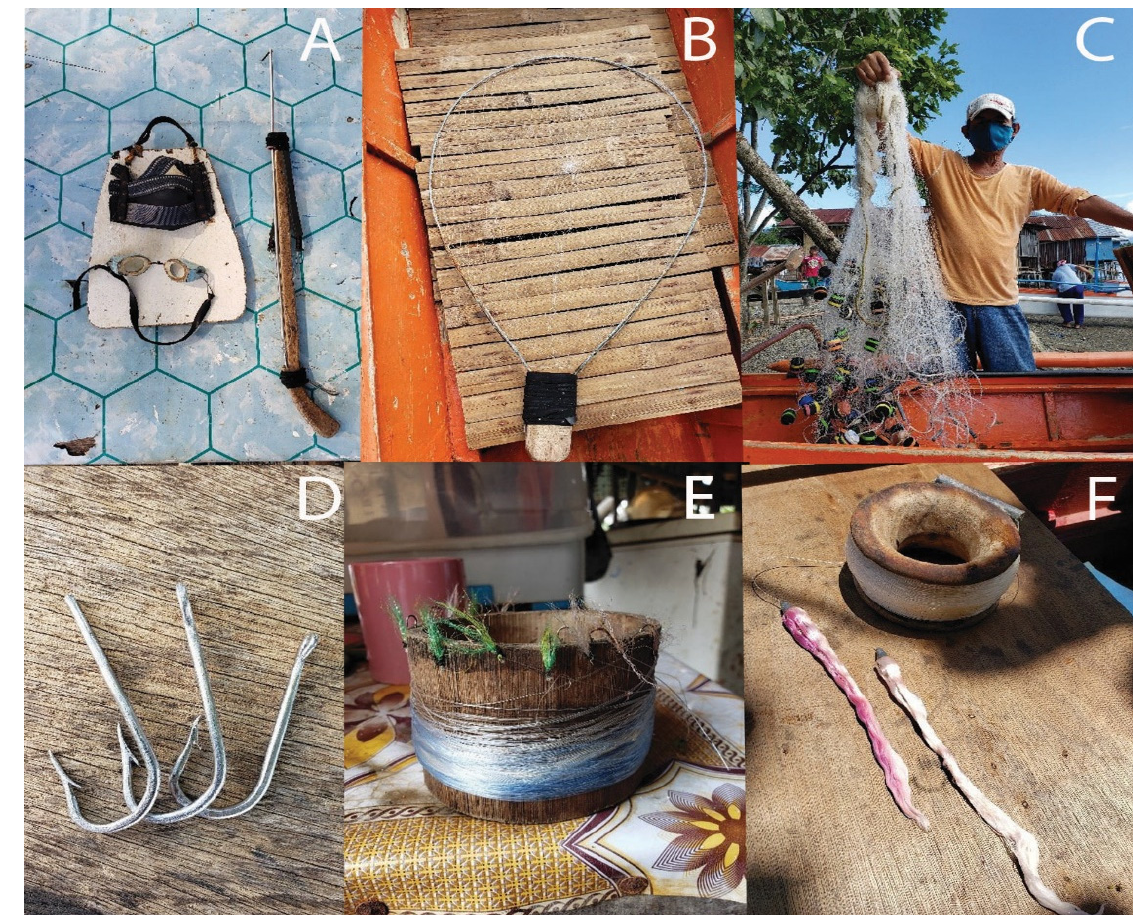
Figure 2. Samples of fishing gears used by small-scale fishers of Governor Generoso and Lupon; ( A ) speargun, ( B ) scoopnet, ( C ) gillnet, ( D ) samples of hooks, ( E ) multiple hook and line, and ( F ) species specific handline.